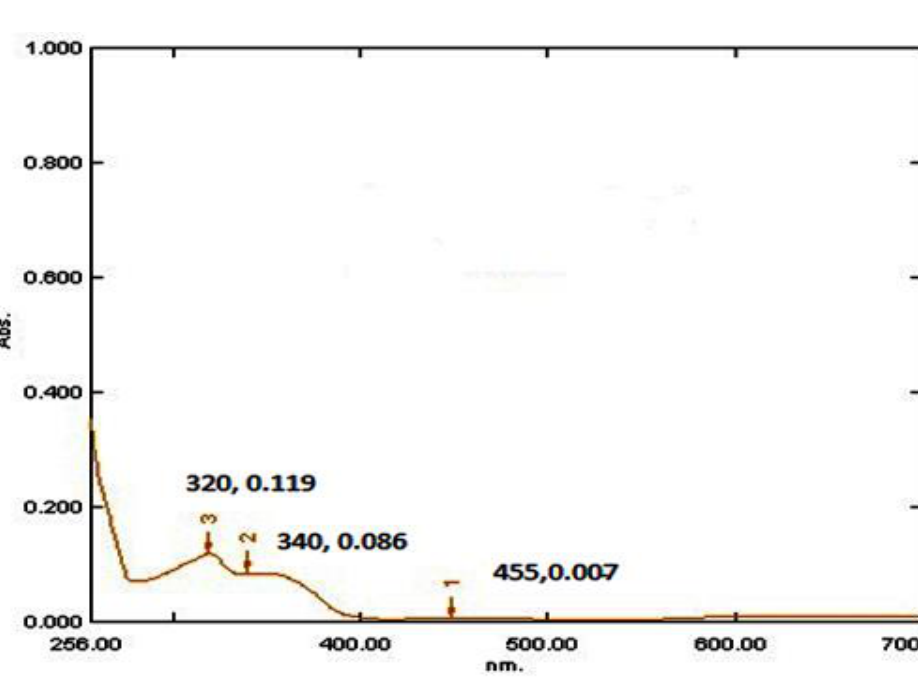
Figure S12: UV/Visible spectrum of dialdehyde monomer o